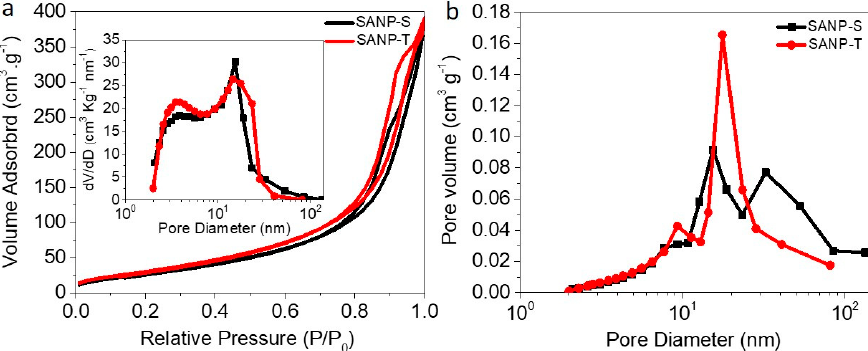
method for powders collected form SANP-S and SANP-T films; ( b ) Pore volueme/pore size distribution for SANP-S and